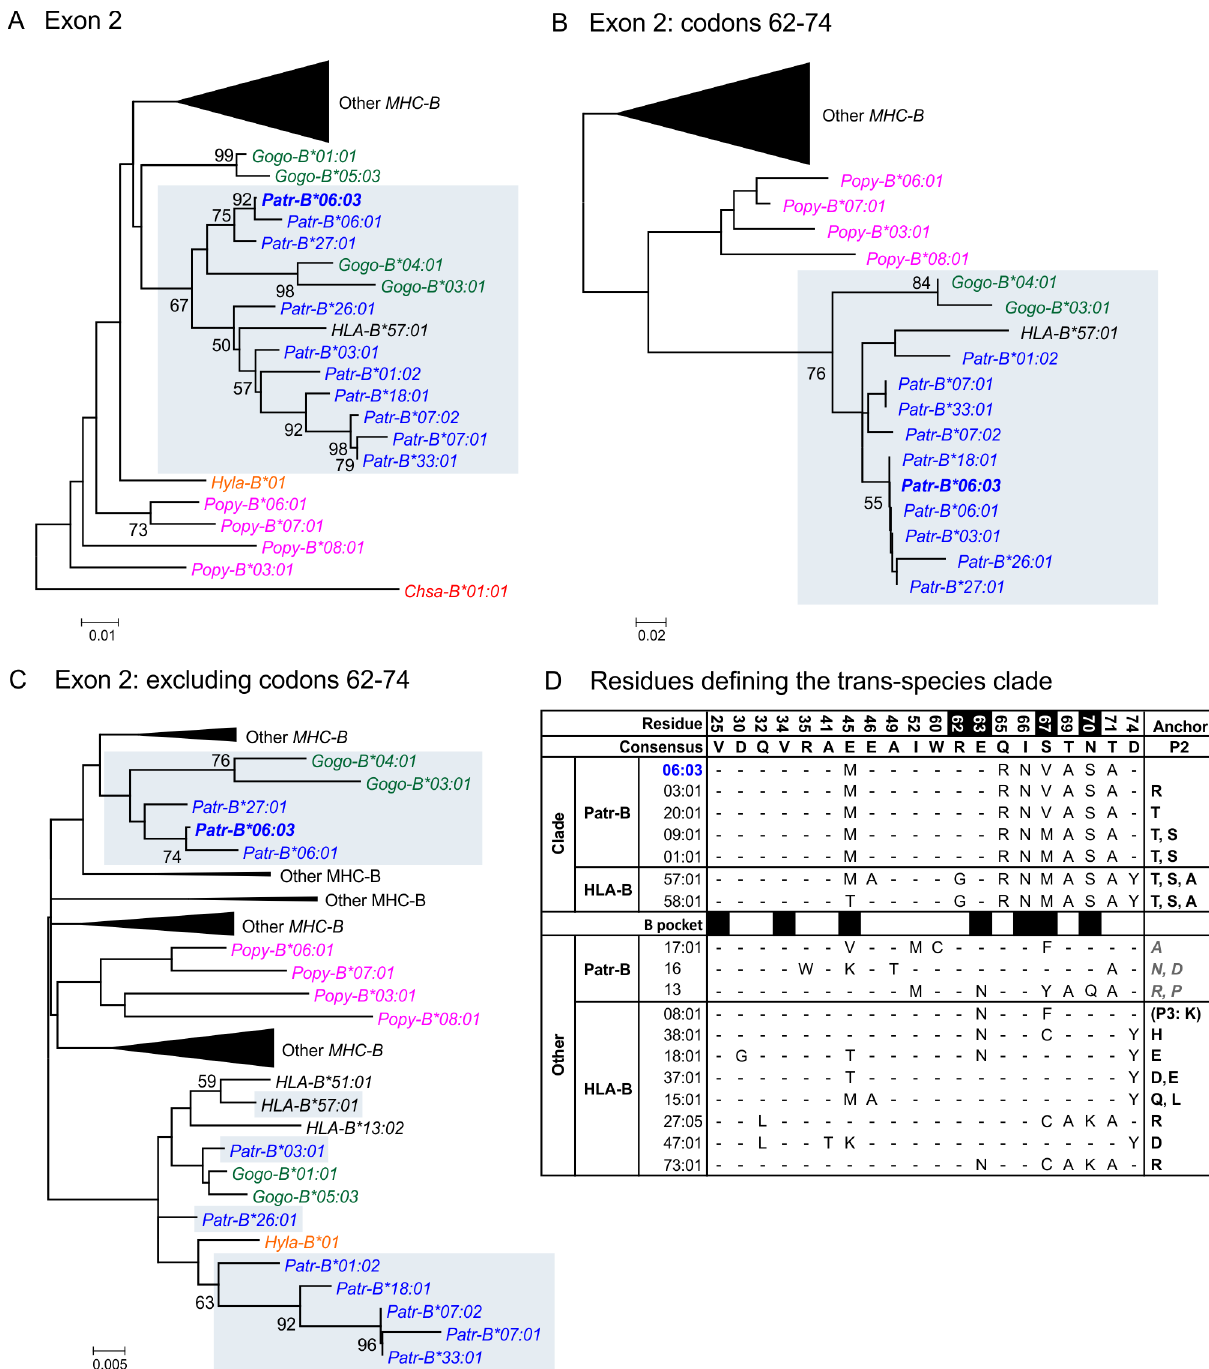
Fig 8. SIVcpz-associated Patr-B * 06:03 is related in structure and evolution to HLA-B * 57:01. Shown is a neighbor-joining phylogenetic tree for the exon 2 sequences of representative MHC-B alleles and the four novel, nonrecombinant Gombe Patr-B alleles (A). An African green monkey ( Chlorocebus sabaeus ) MHC-B is the outgroup ( Chsa , red) in panel A. The gray shaded box denotes the unique clade containing Patr-B * 06:03 (bold blue). This clade is maintained in trees constructed from the sequence of codons 62 – 74 (B), but not in trees constructed from exon 2 sequences with codons 62 – 74 deleted (C). This shows that codons 62 – 74 are the basis for the clade and the relatedness of its members. Nodal bootstrap values are based on 1,000 replications, and only values with at least 50% support are shown. Nodes that were collapsed are represented by large, black triangles. Chimpanzee alleles ( Patr ) are in blue. Also included are human ( HLA , black), orangutan ( Popy , pink), western gorilla ( Gogo , green), and white-handed gibbon ( Hyla , orange) MHC-B . Bonobo ( Papa ) sequences were also included in the analysis, but are within the collapsed nodes. S7 Fig gives the full trees with all the taxa, and the sequences